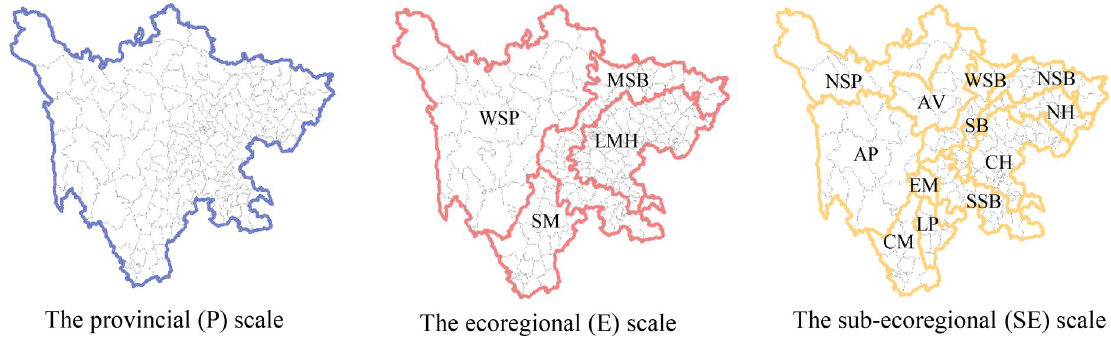
Fig 3. Vector range and unit divisions for the three different spatial scales analyzed in this study. (Reprinted from [Fig 3] under a CC BY license, with permission from [Resource and Environment Science and Data Center], original copyright [2018]).WSP: Western Sichuan Plateau; MSB: Mountains around Sichuan Basin; LMH: Low Mountains and Hills; SM: Southwestern Mountain; NSP: Northwest Sichuan Plateau; AP: Alpine Plateau; AV: Alpine Valley; NSB: Northern Sichuan Basin; WSB: Western Sichuan Basin; SSB: Southern Sichuan Basin; SB: Sichuan Basin; CH: Central Hill; NH: Northern Hill; EM: Emei Mountain; LP: Liangshan Plateau; CM: Central Mountain.